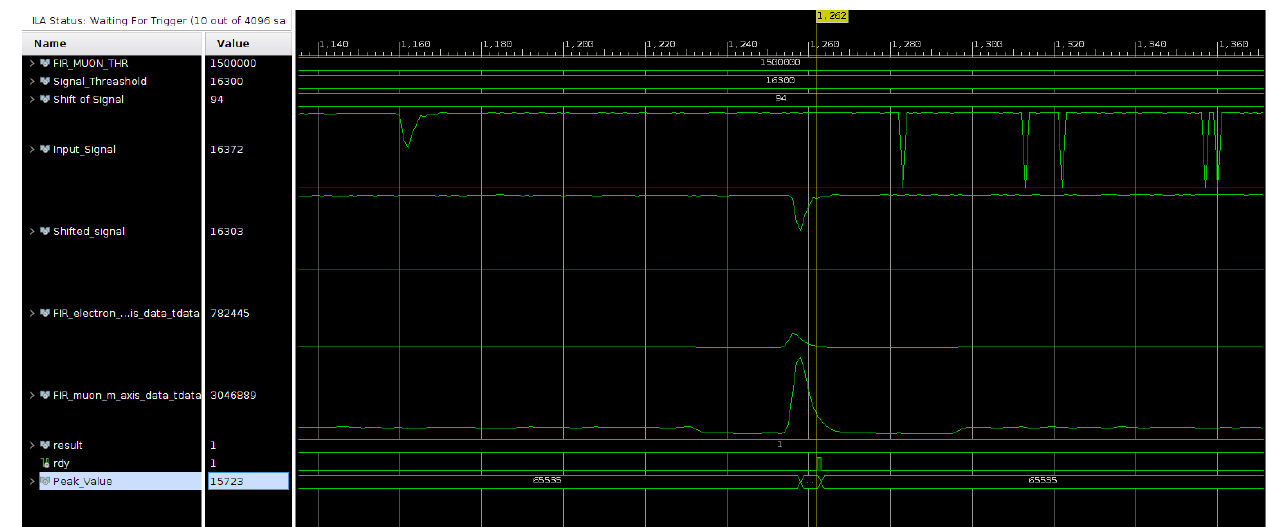
Figure 14. ILA capture of input signals used for selection logic.